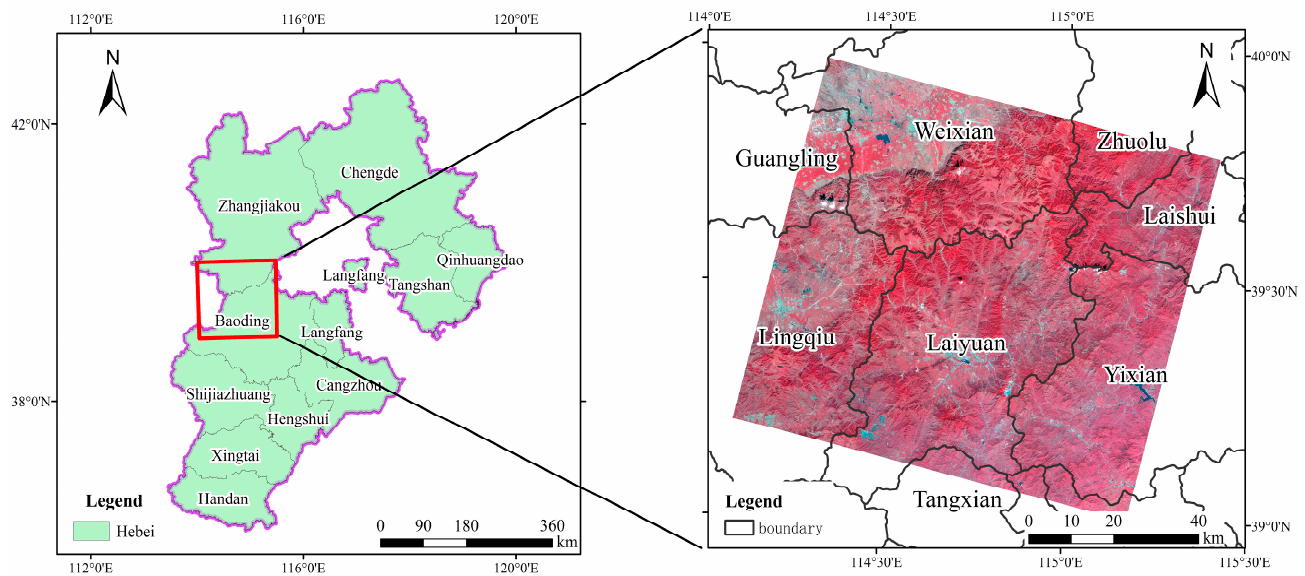
Figure 1. Location of the study area.